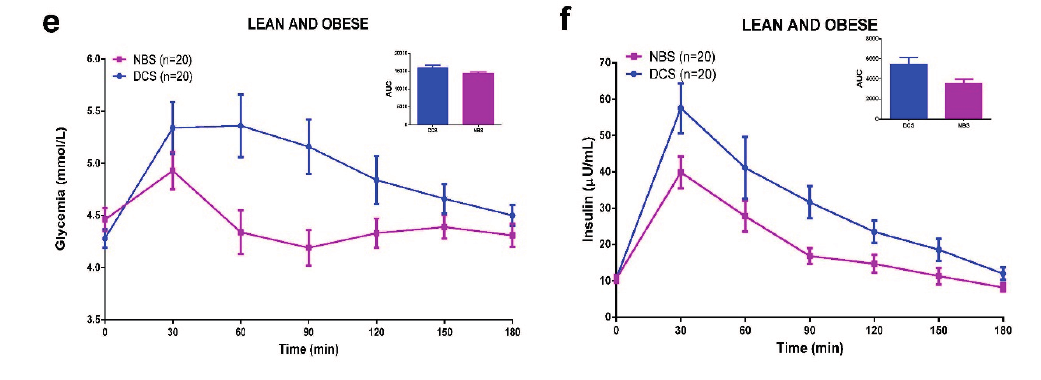
Figure 2. Effects of beverages containing native banana starch (NBS) (red) in comparison with digestible corn starch (DCS) (blue) at the Meal Tolerance Test (MTT) ( a , b ) in lean group; ( c , d ) in obese group; ( e , f ) in lean and obese group. Notes: Beverages were administered 5 min before the standardized food. Areas under the curve (AUC) were compared using a paired Student t test or Wilcoxon test. In ( a ) ANB vs. DCS p = 0.0098; in ( b ) p = 0.0018; in ( c ) p = 0.0223; in ( d ) p = 0.0394; in ( e ) p < 0.0001; in ( f ) p = 0.0002.